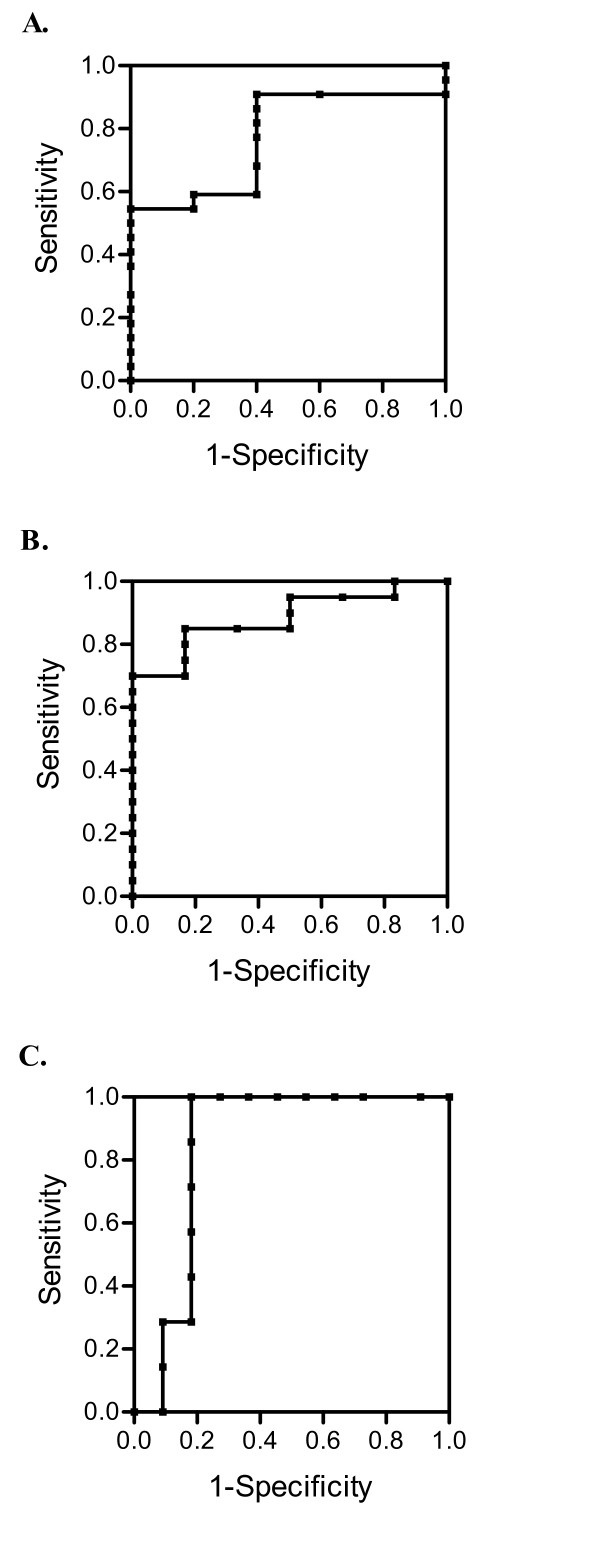
T cell proliferation will detect T cell immunity whether the immune response is low, moderate or robust. ROC curves were plotted to assess the diagnostic performance of the proliferation assay for (A) HER-2/neu ICD specific cellular immunity (n = 27), (B) tt specific cellular immunity (n = 18), and (C) CMV specific cellular immunity (n = 18). Samples with antigen specific circulating antibodies were considered to have positive immunity.